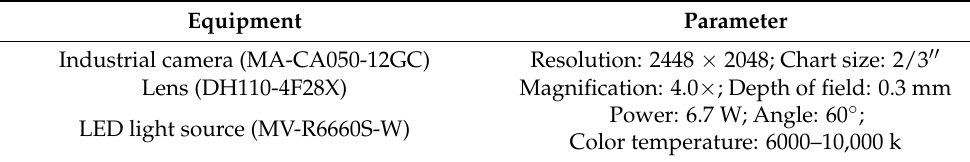
Table 1. Parameter diagram of machine vision equipment.